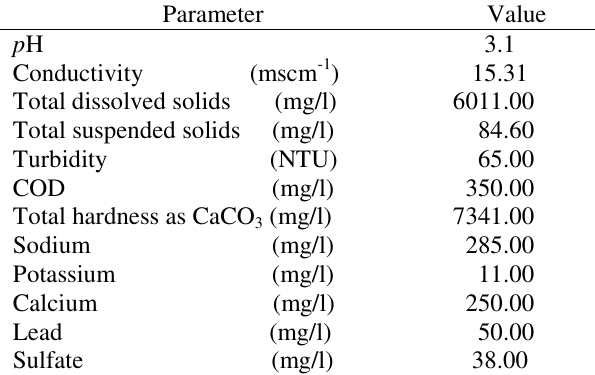
Table 2 Characteristics of Radiator-Manufacturing Industry